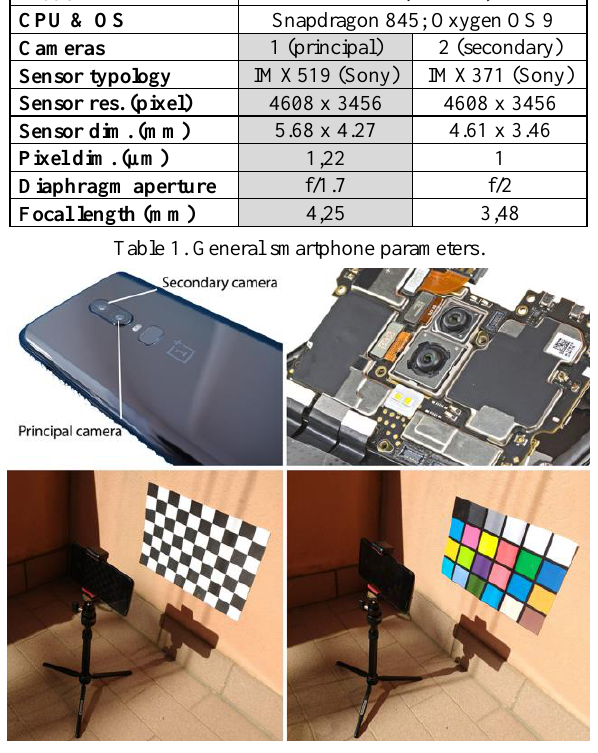
Figure 2. Above the external and internal back view of the A6000 (OnePlus) smartphone, below two testing phases of the smartphone camera with b/w and coloured targets.